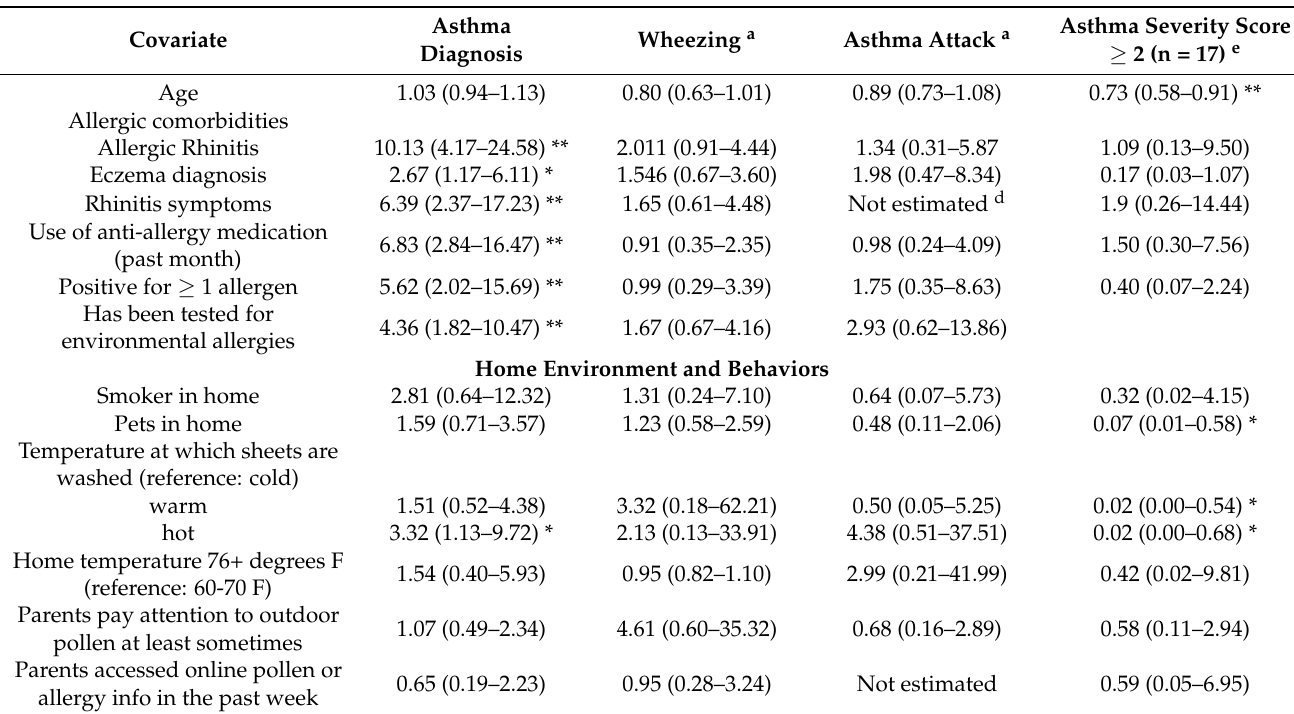
Table 4. Age and gender-adjusted odds of asthma, asthma attack, and wheezing with respect to selected covariates (95% confidence